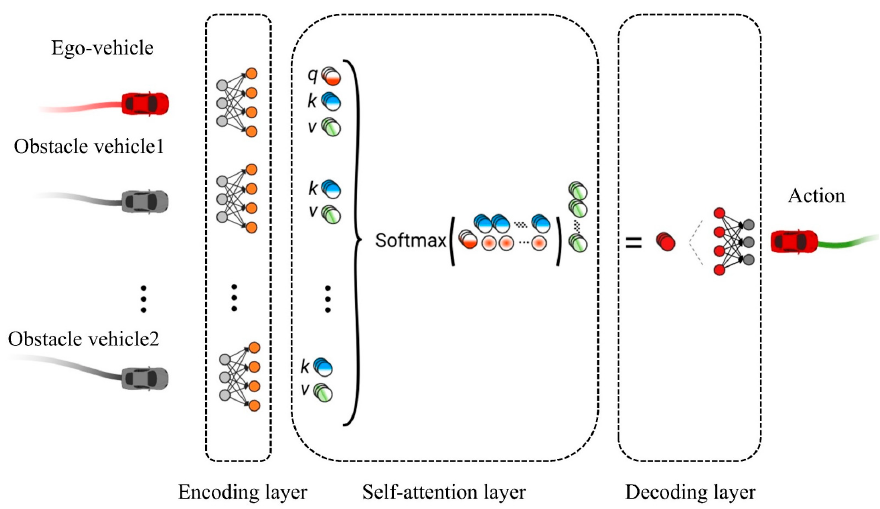
Figure 5. Self-attention network framework.